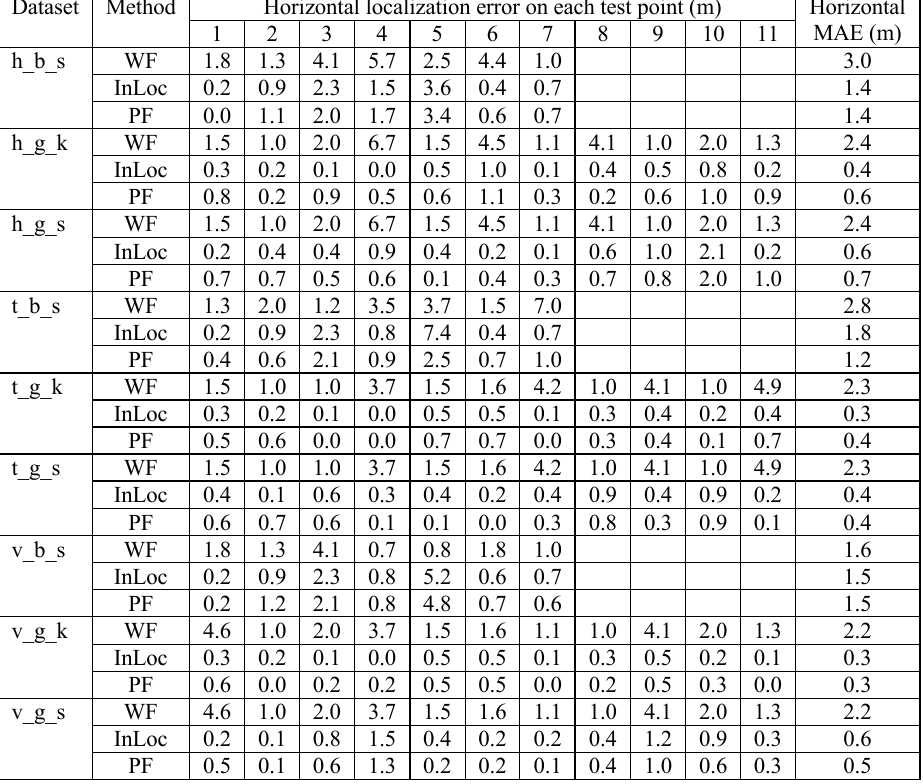
Table 5. Horizontal localization performance of proposed system with particle number =